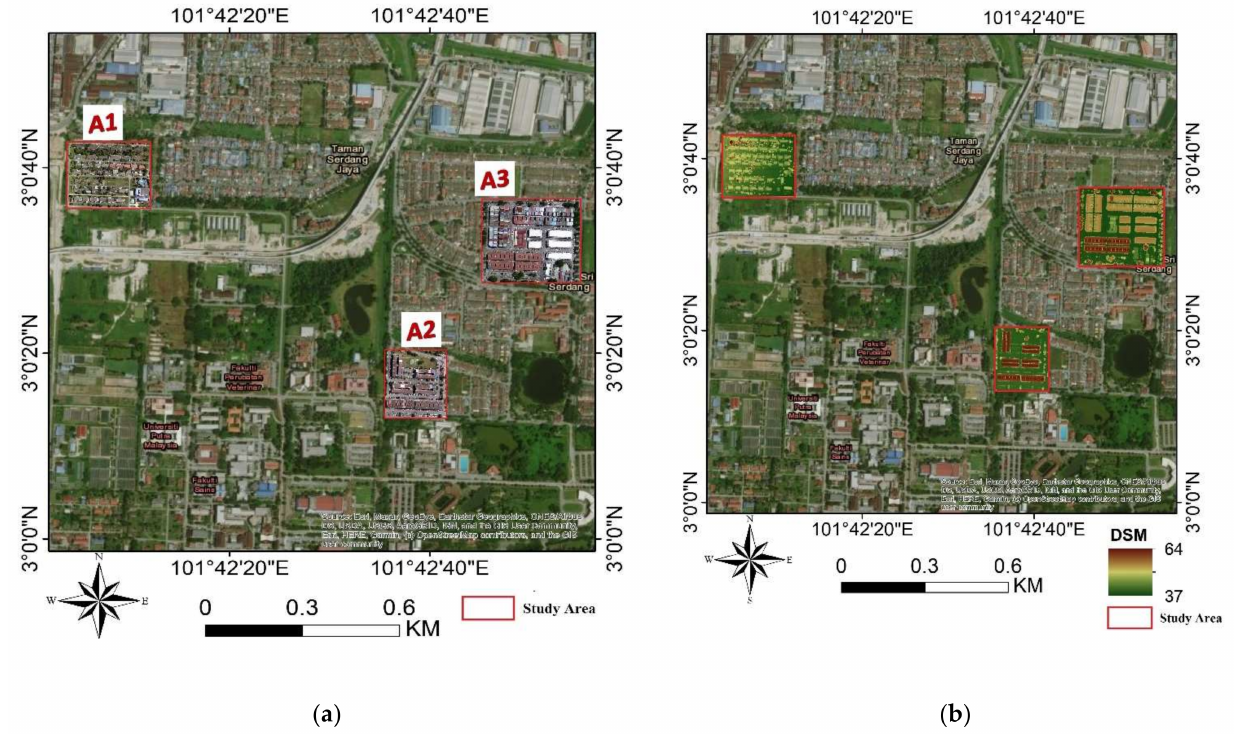
Figure 1. Wide-ranging whereabouts of study area: ( a ) aerial imageries for study areas A1, A2, and A3 and ( b ) digital surface model (DSM) for study areas A1, A2, and